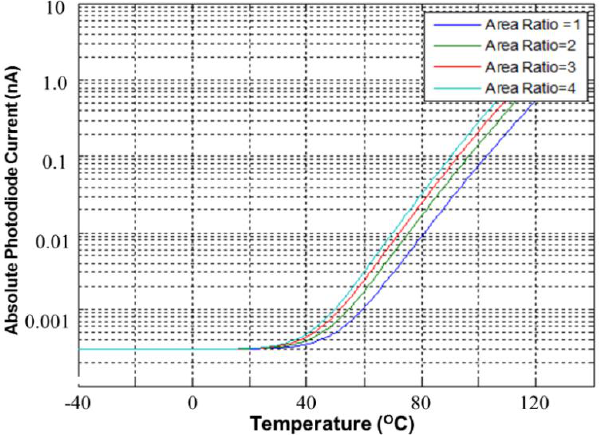
Figure 4. Simulated PD (dark) current versus standardized area ratio in dark conditions.